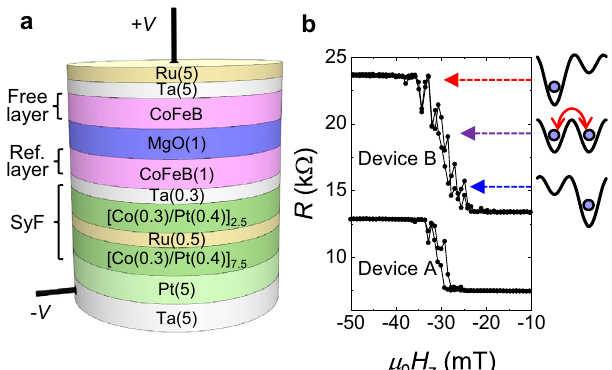
Fig. 1 Sample structure and R – H z property. a Stack structure of the magnetic tunnel junction. b Resistance R as a function of external perpendicular magnetic fi eld H z